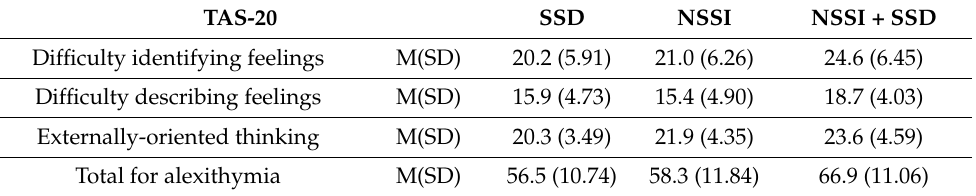
Table 3. Mean scores obtained by the three study groups on the Toronto Alexithymia Scale (TAS-20) scales.